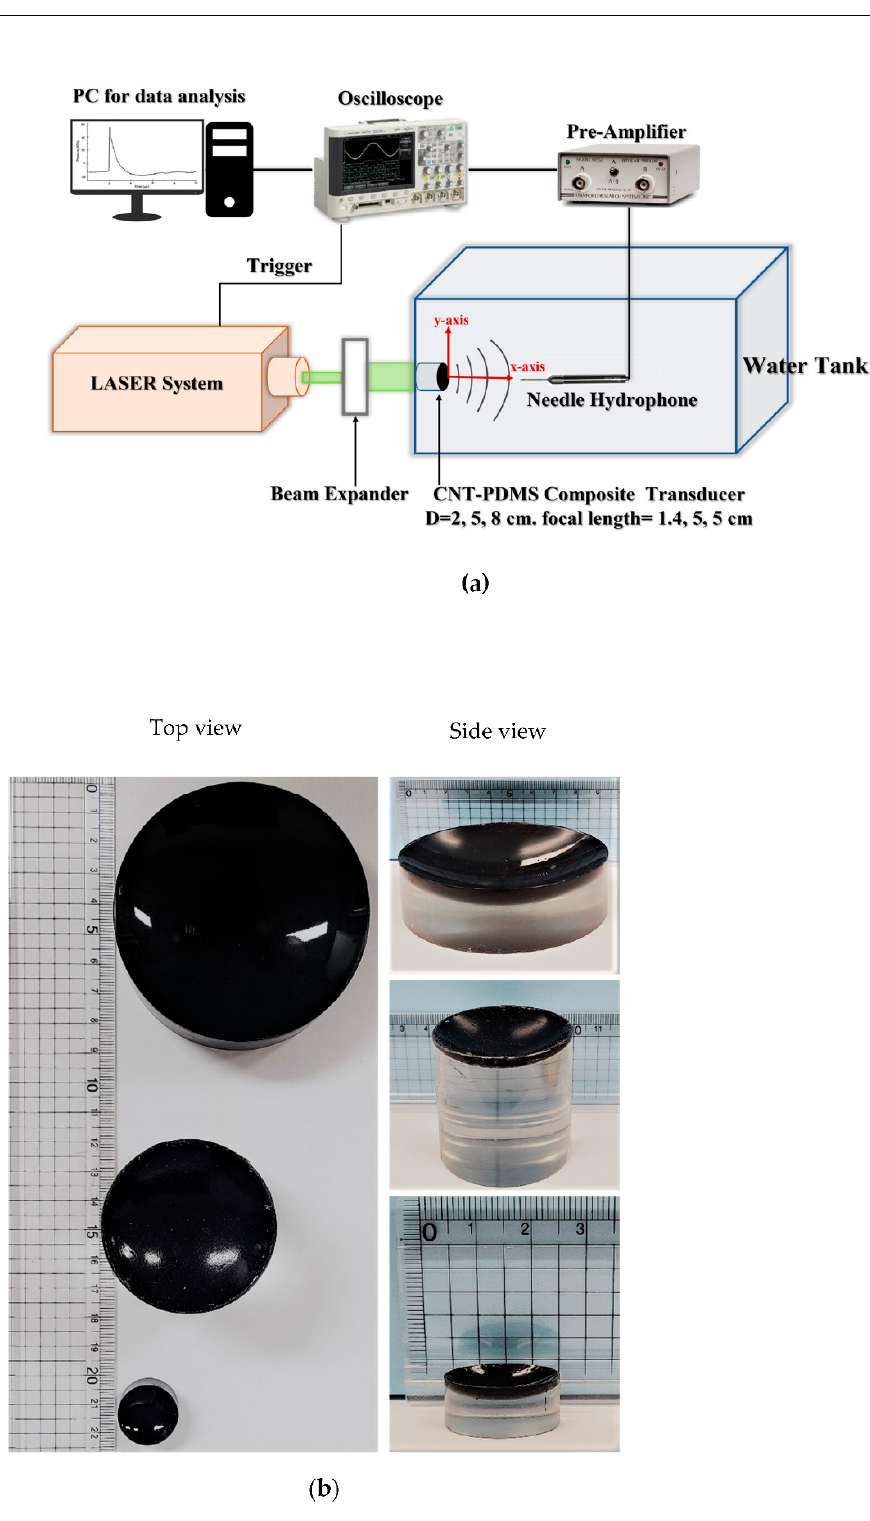
Figure 1. ( a ) Experimental setup for shock wave generation and measurement. The CNT-PDMS composite transducer was mounted inside a degassed water tank and aligned with the laser system (Q-switched Nd: YAG laser (STL-5000Q, Stratek, Anyang-si, Korea). The needle hydrophone (NH0200, Precision Acoustics Ltd., Dorchester, UK) collected the shock wave signal generated from the CNT-PDMS composite transducer, which was then amplified by a pre-amplifier (HP Precision Acoustics. Ltd., Dorchester, UK) and sent to the oscilloscope (LT354, Lecroy, New York, NY, USA). The signal data from the oscilloscope were fed to a PC for analysis. ( b ) CNT-PDMS composite transducers of different sizes were used in the experiment. The top view of 2 cm, 5 cm, and 8 cm transducers, along with their side view, are presented.